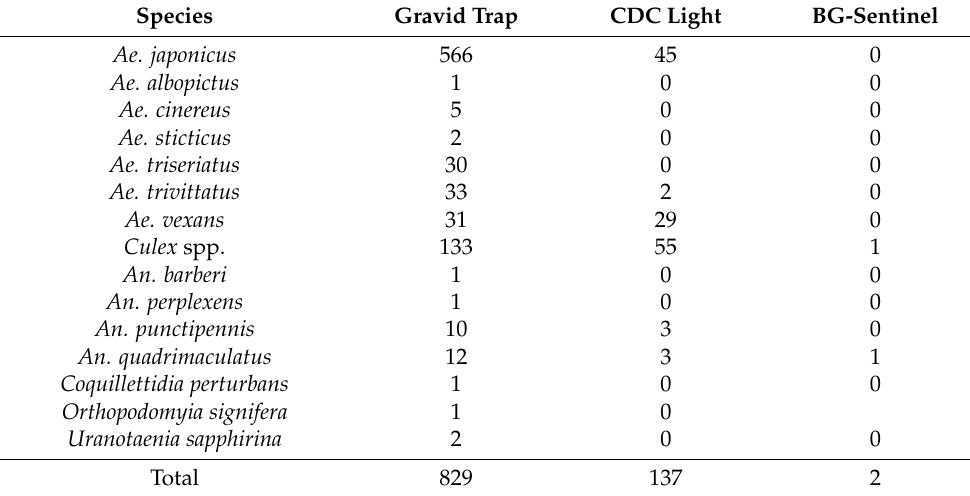
Table 2. Abundance of collected mosquitoes during 61 nights using four traps of CDC light and gravid traps, and two BG traps. The night trap effort was 244 for the gravid trap and CDC light and 122 for the BG traps. These latter were less used than other traps because of their poor